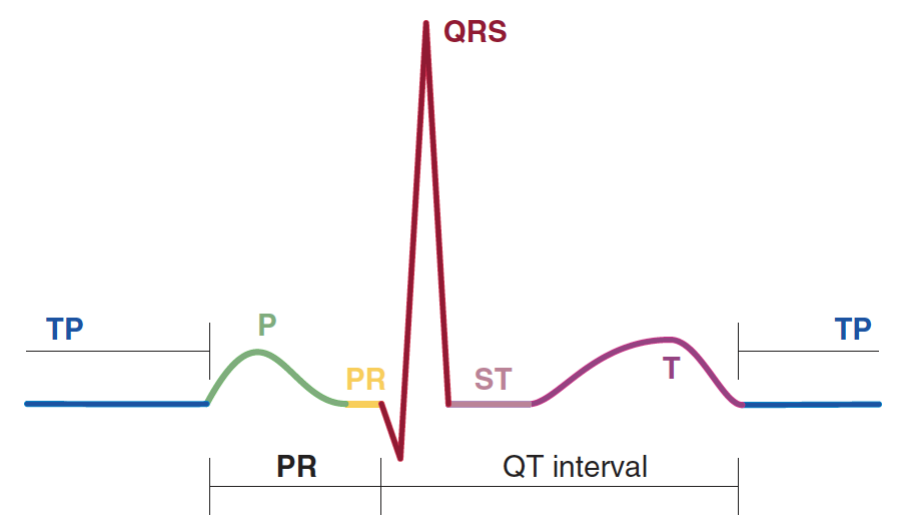
Figure 3. A single cardiac cycle of the ECG